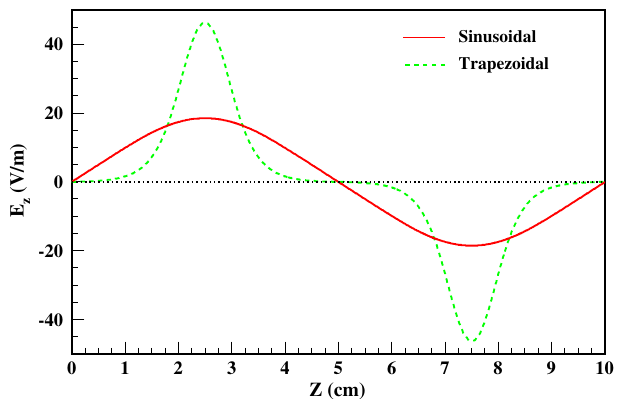
FIG. 4. Accelerating field distribution in the RFQ with sinu- soidal (solid red line) and trapezoidal (dashed green line) mod-